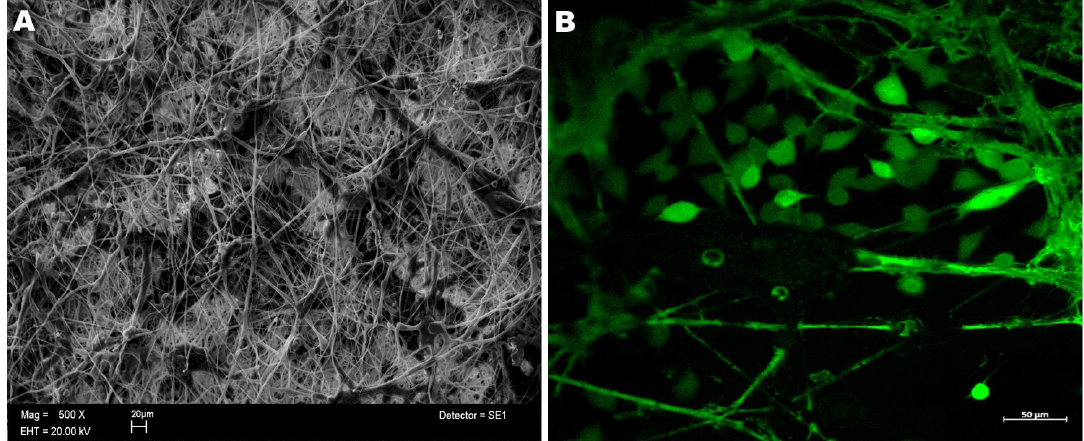
Figure 11. Representative SEM (A) and fluorescence (B) micrographs showing the morphology and spreading pattern interaction of hFOB cultured onto seeded PLA/SBA‑15 fiber composite with 0.05